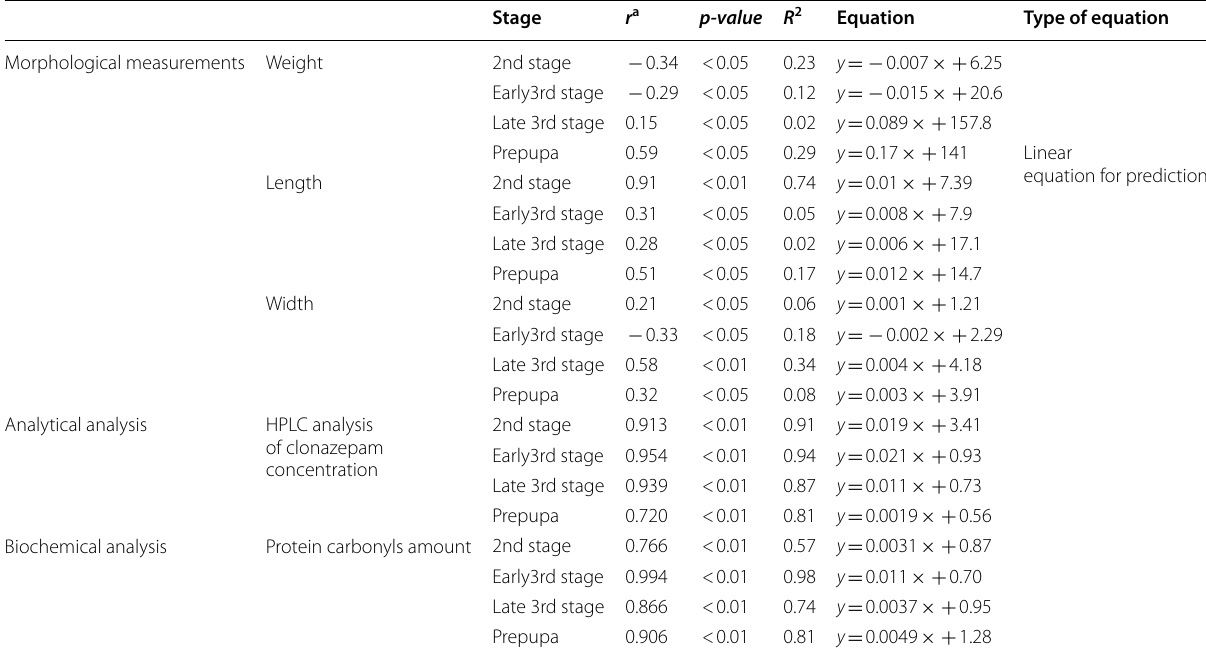
a Pearson correlation coefficient (two-tailed test)